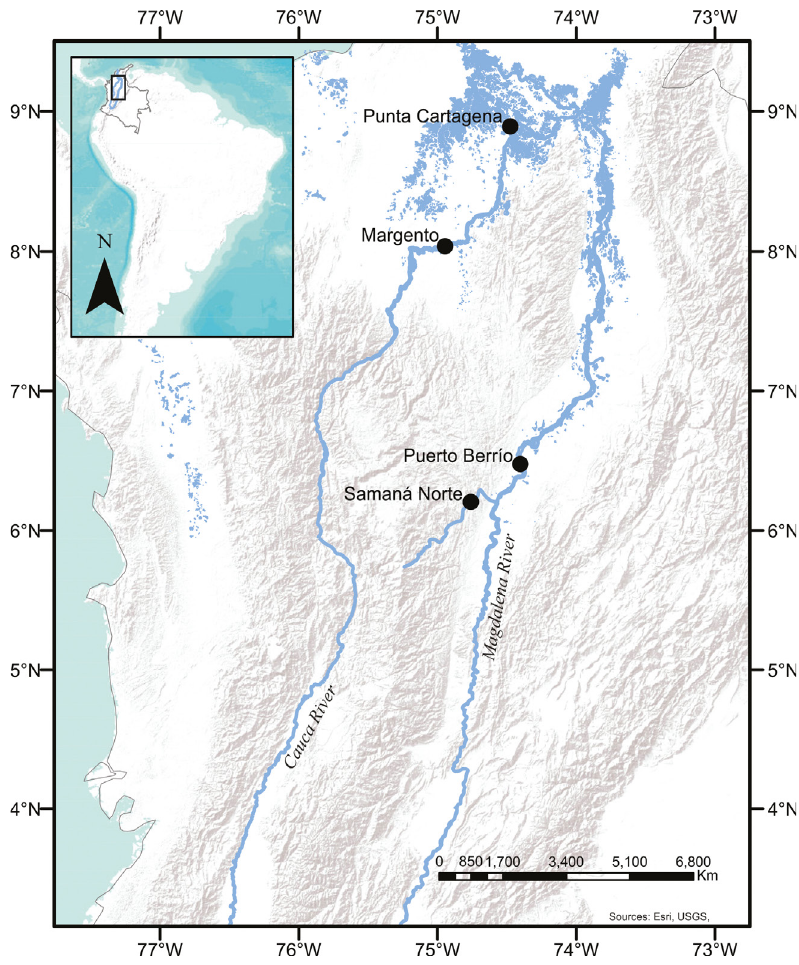
FIGURE 1 | Sampling sites of Pseudoplatystoma magdaleniatum in the Magdalena-Cauca